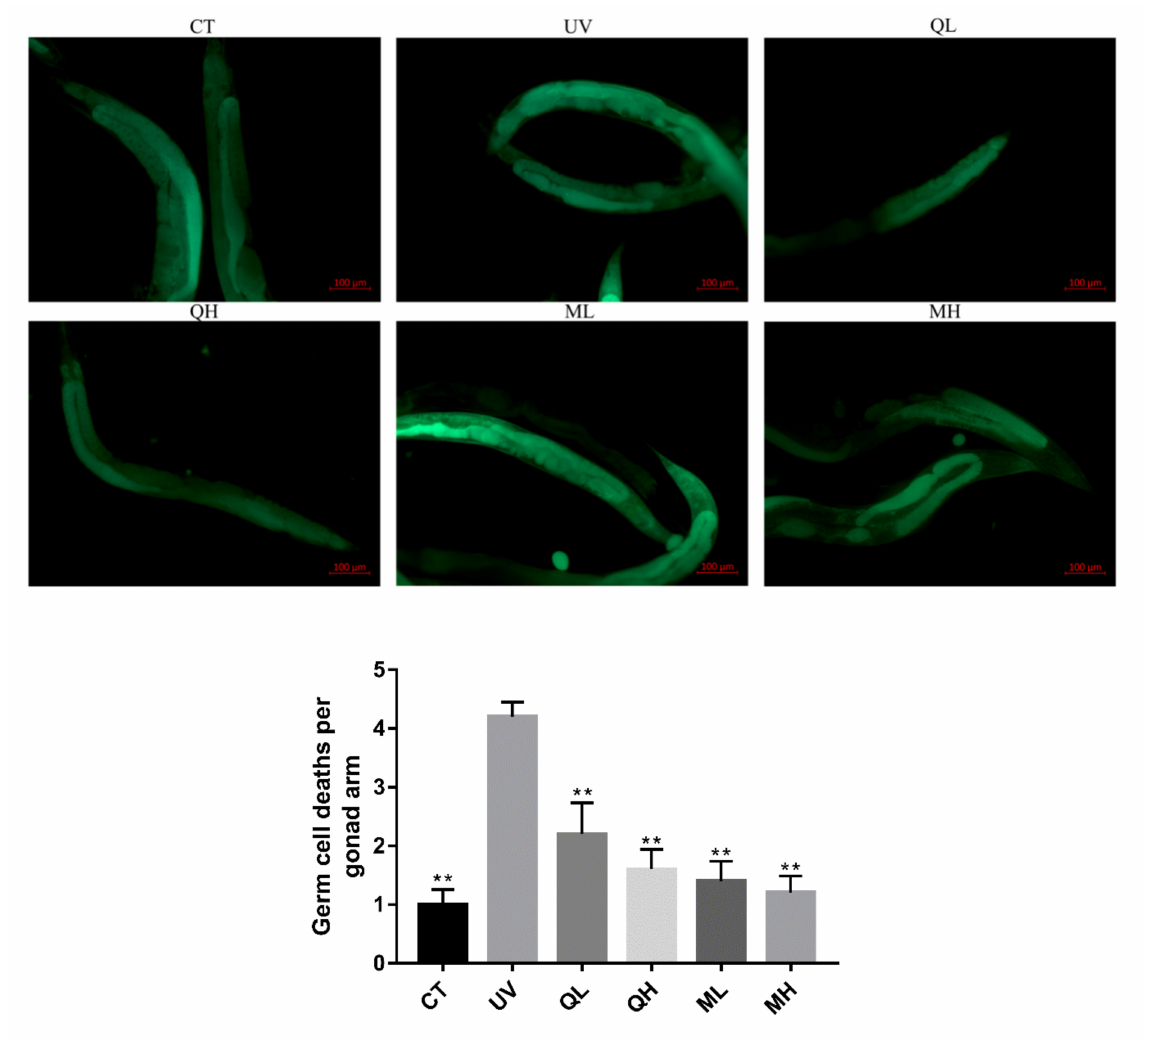
Figure 5. Apoptosis results of gonad arm cells of every group 6 h after UV-B irradiation at a dose of 100 J / M 2 . These pictures were taken in a 100 × field of view (FITC). The tiny yellow-green foci in the picture are the apoptotic cell stained by AO. All data are mean ± SEM and were analyzed by two-tailed Student’s t -test, n = 10, * p < 0.05, ** p < 0.01 compared to UV